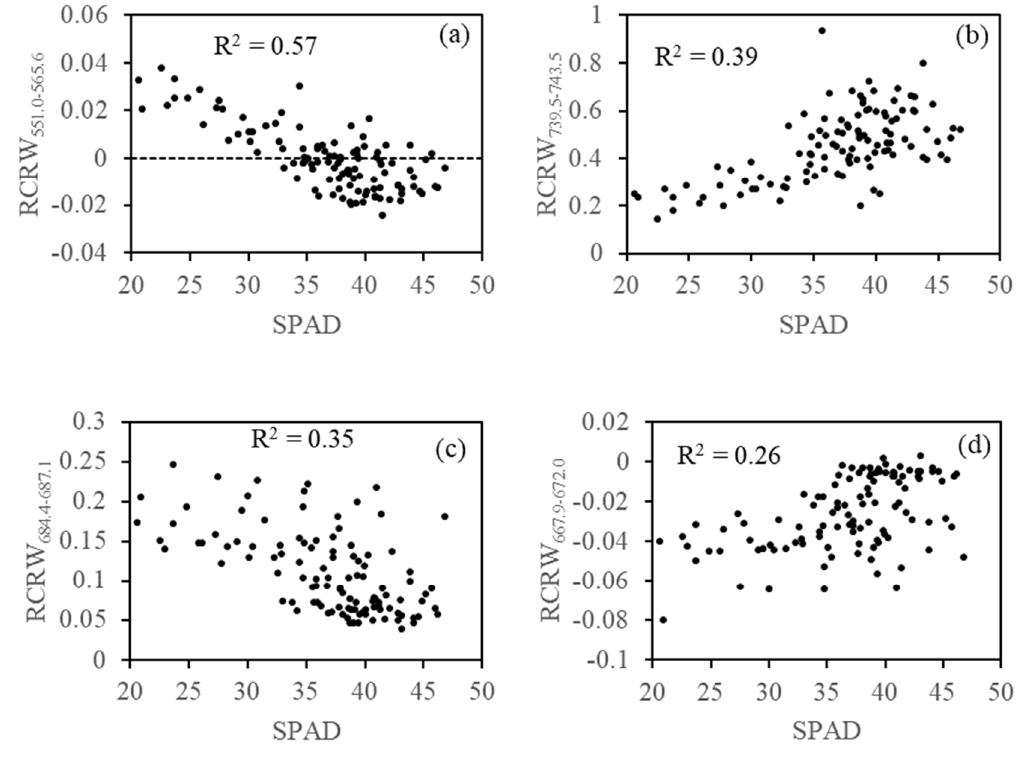
Figure 9. Scatter plots between ( a ) SPAD and RCRW 551.0–565.6 , ( b ) SPAD and RCRW 739.5–743.5 , ( c ) SPAD and RCRW 684.4–687.1 , ( d ) SPAD and RCRW 667.9–672.0